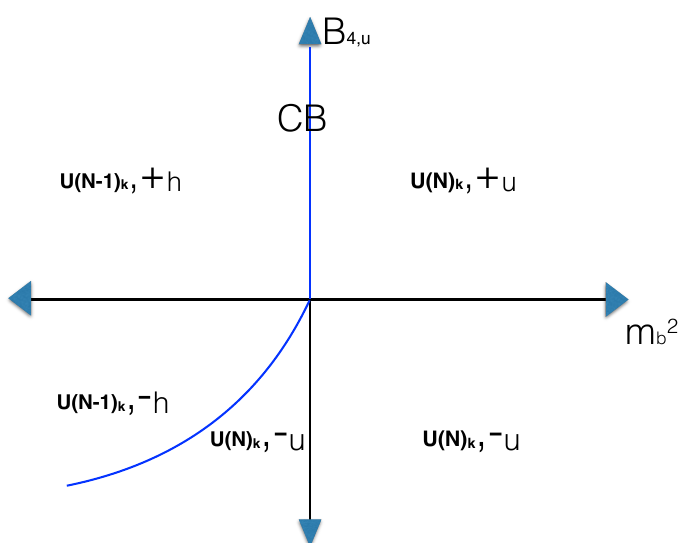
Figure 7. The phase diagram for (cid:30) 1 < x 6 < (cid:30) 2 . For B 4 ;u > 0 we have a second order phase transition at m 2 = 0 between + u and + h phases. For B 4 ;u < 0, the blue line is a (cid:12)rst order b phase transition between the region in which the solution is the dominant phase and the region (cid:0) u in which the solution dominates. Note that the (cid:12)rst order phase transition is at m 2 > 0 for b (cid:0) h x 6 > ( (cid:30) 1 + (cid:30) 2 ) = 2, but it is at m 2 < 0 otherwise. Our schematic phase diagram has been sketched b for the latter